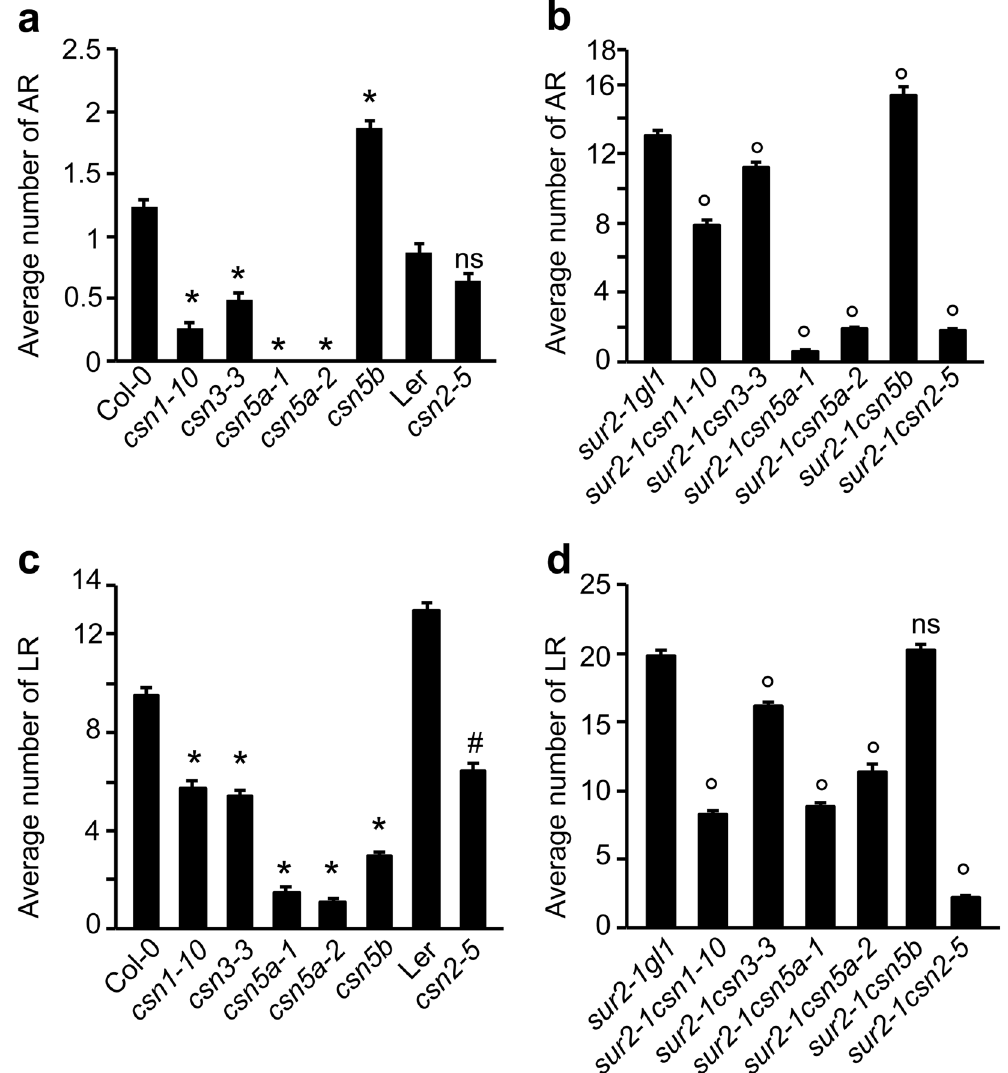
Figure 5. CSN subunits play differential roles in AR and LR formation. (a,b) Adventitious roots were counted on seedlings first etiolated in the dark, until their hypocotyls were 6 mm long, then transferred to the light for 7 d, and averaged. (c,d) Numbers of emergent lateral roots were counted on seedlings grown in vitro directly in light conditions for 10 d and averaged as described in the Methods. At least 30 seedlings of each line were analyzed, the experiments were repeated three times and the data pooled. Error bars indicate standard error; A one-way ANOVA combined with Dunnett’s comparison post-test was used to compare single mutant lines with their respective wild type, and double mutant lines with sur2-1gl1 ; ( * ) indicates values significantly different from Col-0 values; (#) indicates values significantly different from L er values; (o) indicate values that were significantly different from sur2-1gl1 values; ns indicates values not significantly different from L er ( c ) or sur2- 1gl1 ( d ) values (P < 0.05; n > 90